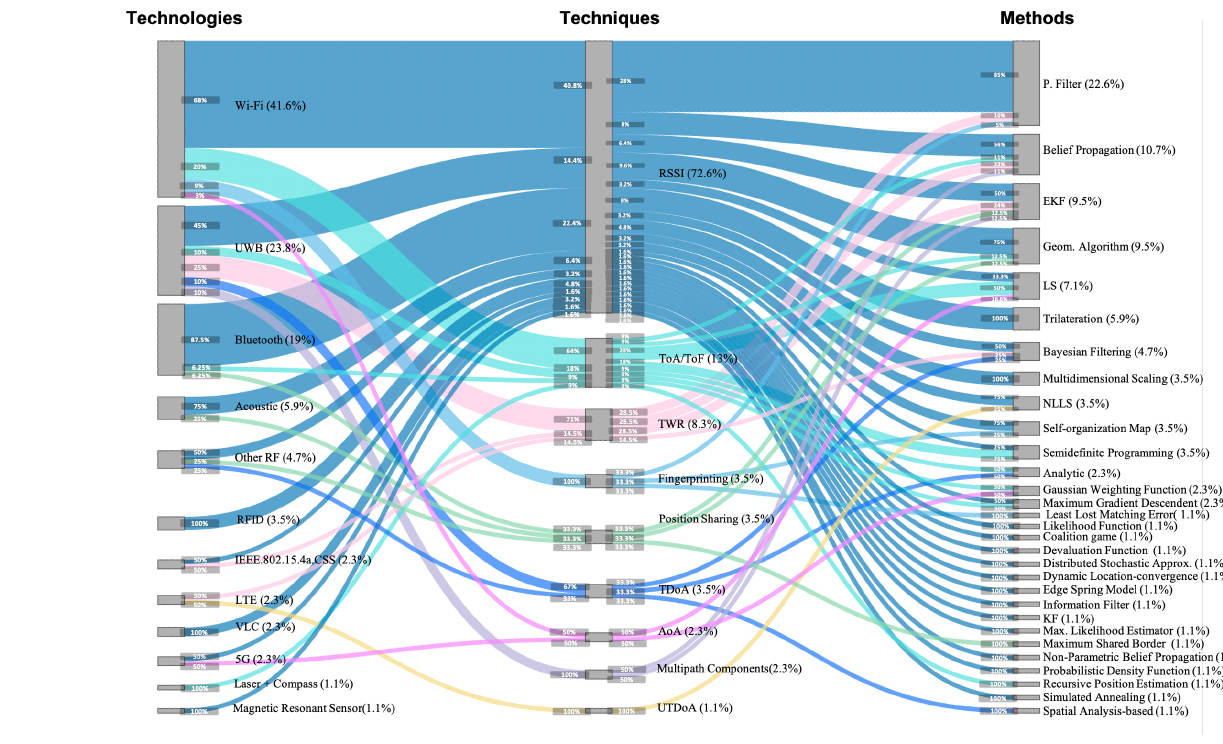
Figure 6. Collaborative technologies, techniques, and methods in CIPS. Source: